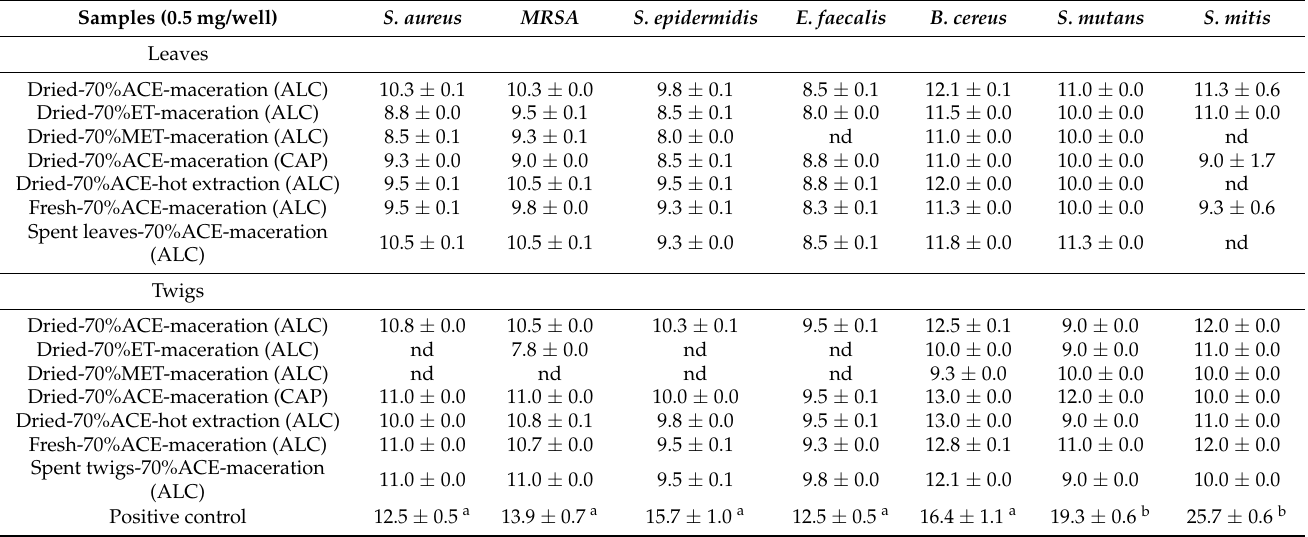
Table 6. Inhibition zones (mm) of selected extracts of A. dealbata leaves and twigs against S. aureus , MRSA, S. epidermis , E. faecalis , B. cereus , S. mutans and S. mitis